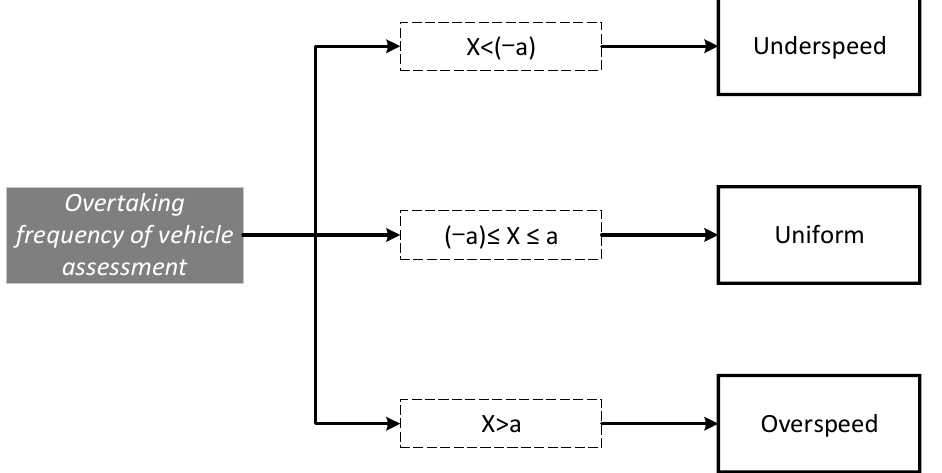
Figure 3. Judgment framework for overtaking frequency